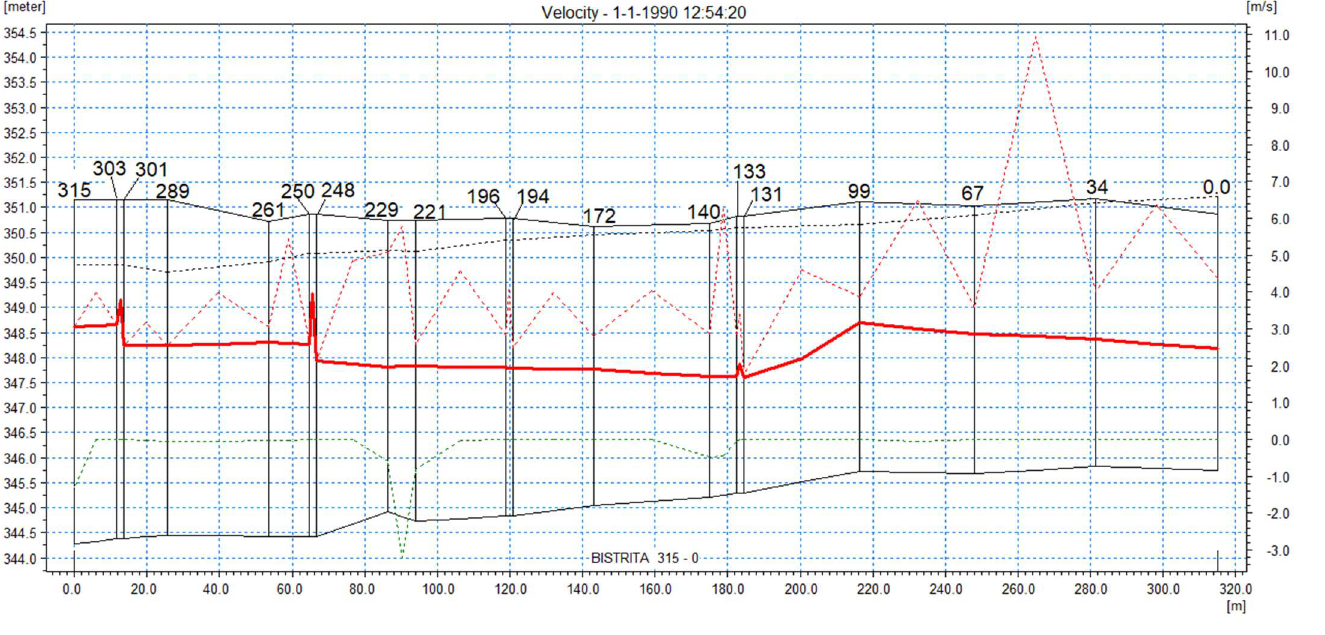
Figure 17. Water speed for flow Q = 128 m 3 /s, representing an extreme flood flow recorded in 2020. For the proposed case with the lowering of the crest of the existing weir and the construction of three new weirs of low height downstream of it.